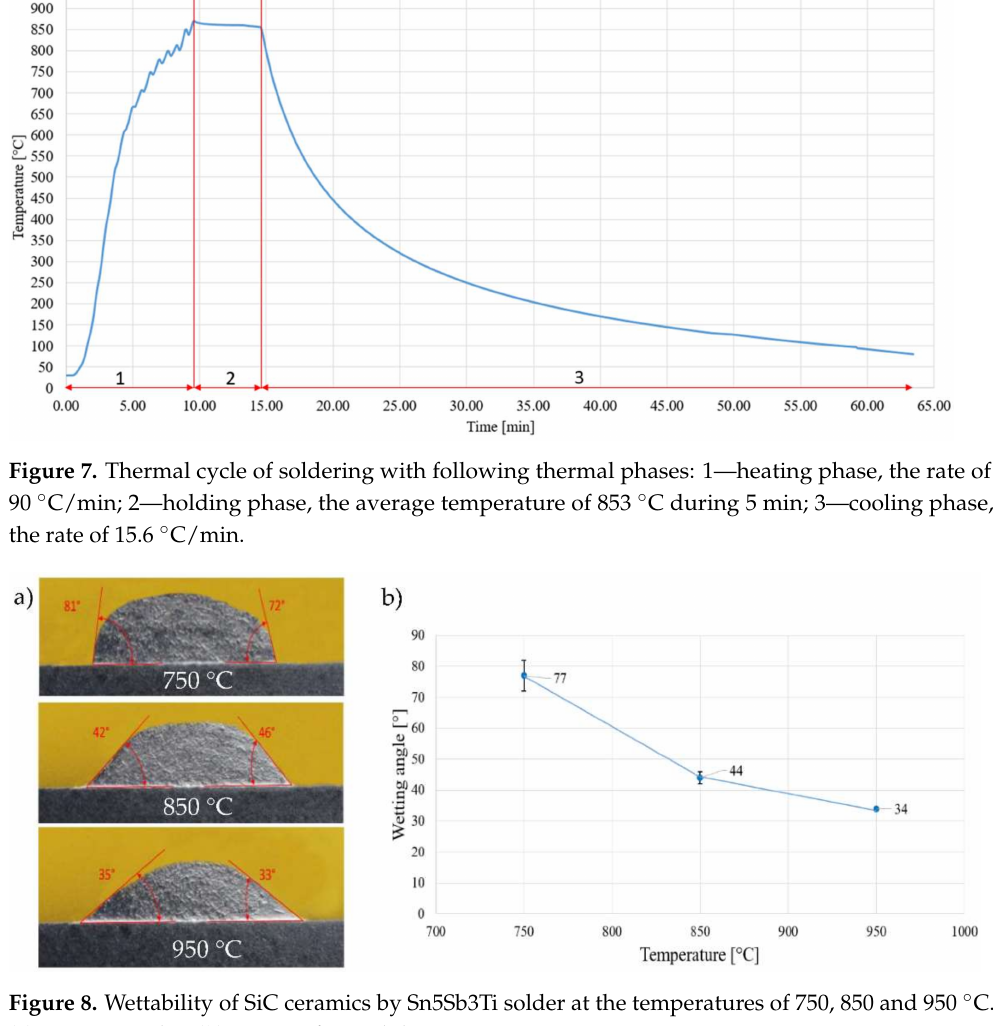
Figure 8. Wettability of SiC ceramics by Sn5Sb3Ti solder at the temperatures of 750, 850 and 950 ◦ C. ( a ) wetting angles; ( b ) course of wettability